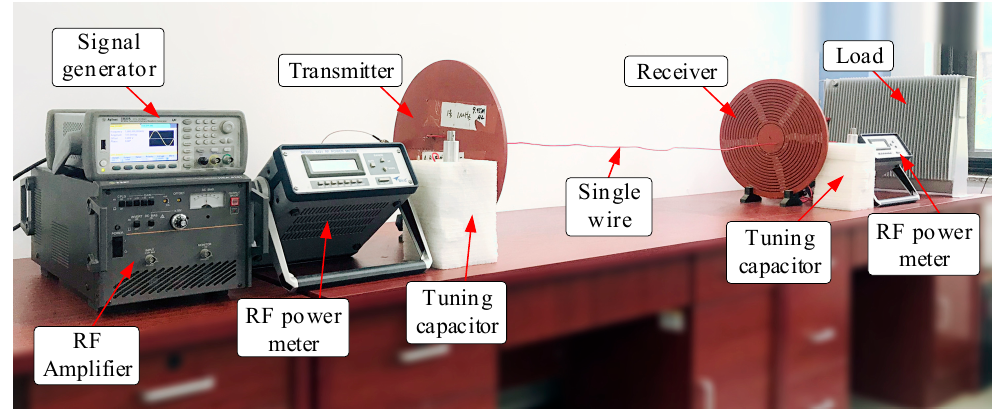
Figure 10. Experimental platform of the single-wire power transfer system.